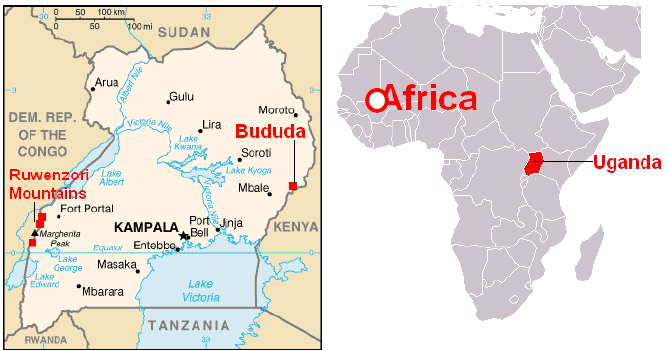
Figure 1. Map of Uganda showing position of Lira municipality.